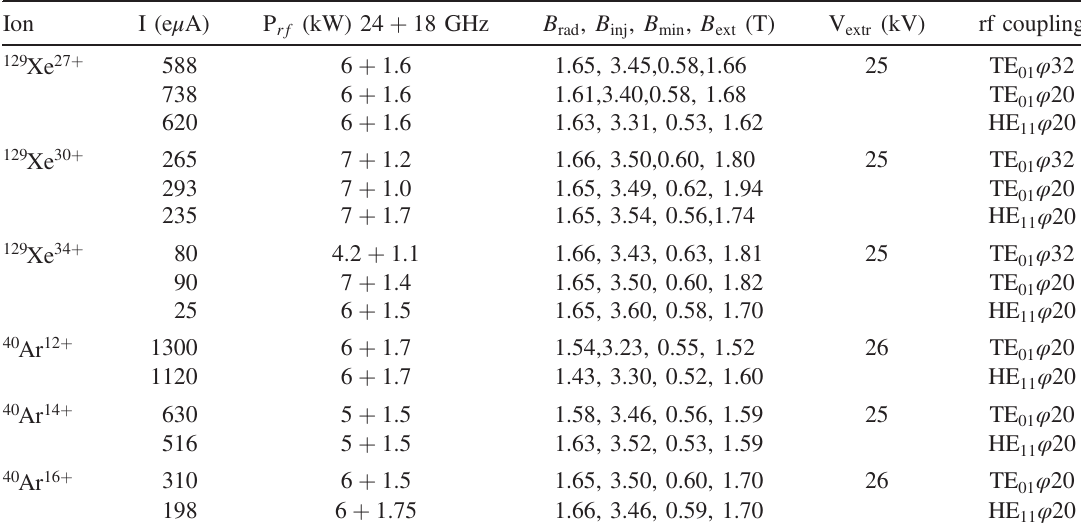
TABLE I. Comparison of typical beams and the beam intensities at the similar microwave power level by using different wave coupling schemes.